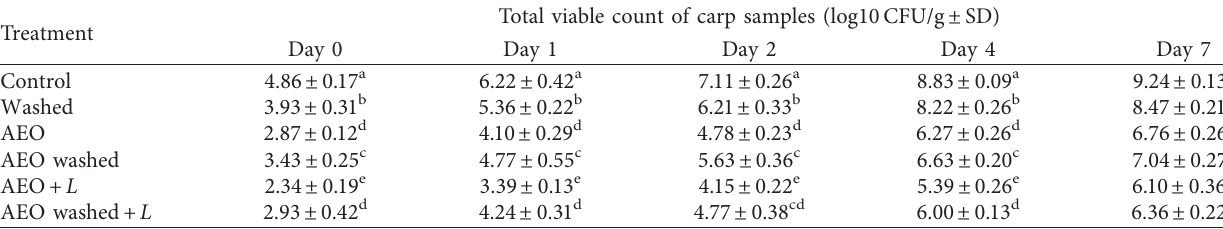
Table 1: Effects of washing, acidic electrolyzed oxidizing water, and lysozyme treatments on the total viable count of carp samples. Treatment